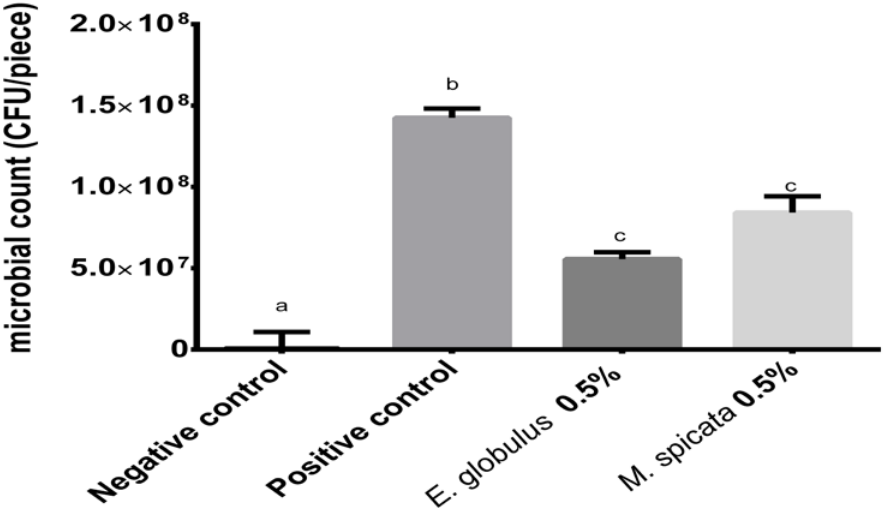
Figure 4. Recoverable microorganism count. The letters indicate which groups had a statistically significant difference with a confidence interval above 95%.